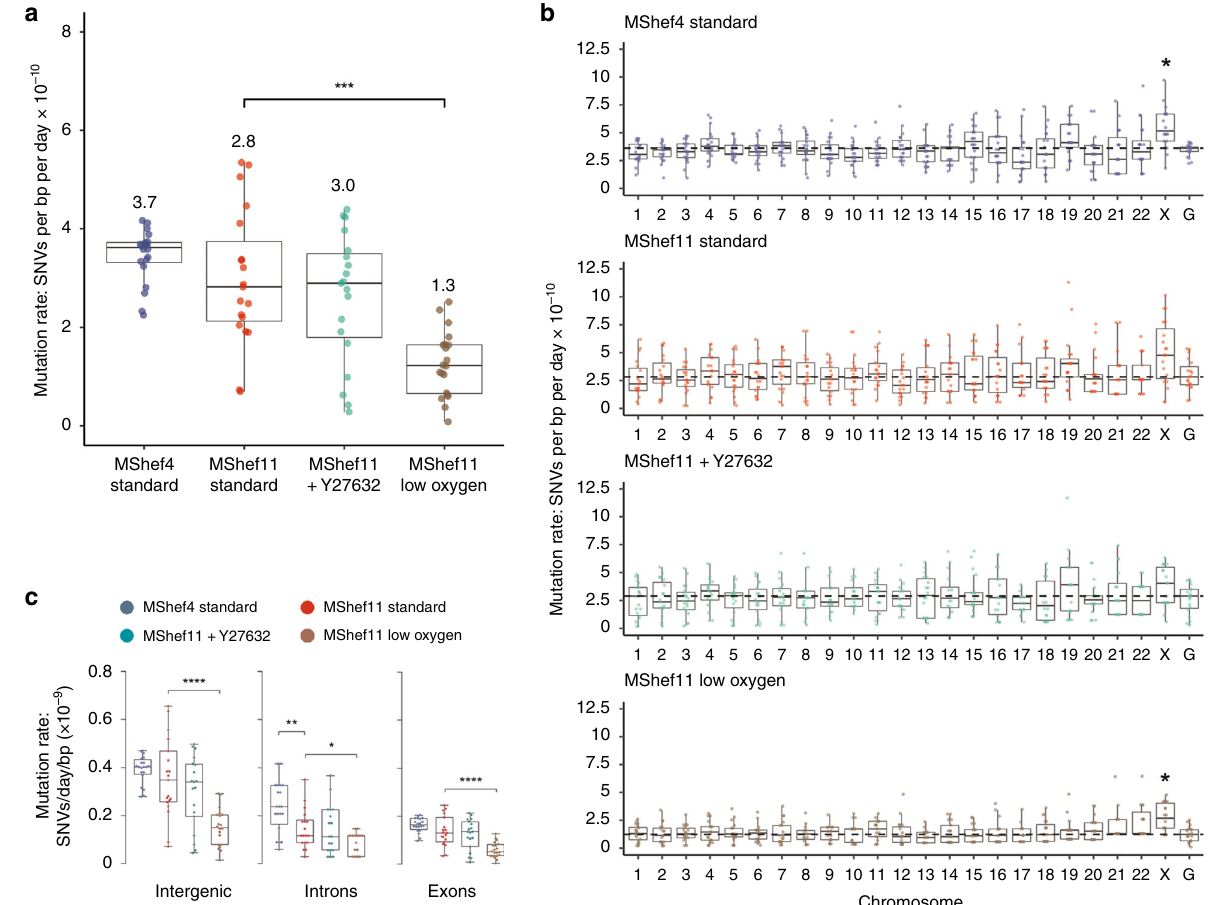
Fig. 2 Mutation rate and genomic distribution of single-nucleotide variant mutations in different growth-conditions. Box and whisker plots showing haploid mutation rates and genomic distribution of single-nucleotide variant mutations in subclones of MShef4 ( N = 20) and MShef11 ( N = 19) grown under standard conditions, and subclones of MShef11 cultured with the rho-kinase inhibitor Y27632 at passage ( N = 20) or cultured in low oxygen ( N = 21). Boxes represent 25th – 75th percentiles; whiskers show the min and max ranges; horizontal lines indicate the median values. a The median mutation rates (shown below each plot) for MShef4 and MShef11, cultured in standard conditions, and MShef11 cultured with the rho-kinase inhibitor Y27632 were not signi fi cantly different. However, MShef11 cultured in low oxygen exhibited a ~54% lower mutation rate (unpaired two-tailed t -tests with Welch ’ s correction; P = < 0.0001). ns: P > 0.05; * P ≤ 0.05; ** P ≤ 0.01, *** P ≤ 0.001; **** P ≤ 0.0001. b Across all chromosomes only the X-chromosome mutation rate deviated from the genome-wide rates, being elevated in all growth conditions, although only signi fi cant in MShef4 and MShef11 under low oxygen, assessed by independent pairwise two-tailed Mann-Whitney tests comparing the median genome-wide rate in each condition with that of each chromosome (Bonferroni-adjusted P = < 0.007; P = < 0.034). When data from all growth conditions were combined, the elevated X-chromosome mutation rate remained signi fi cant ( P = < 0.05). ns: P > 0.05; * P ≤ 0.05; ** P ≤ 0.01, *** P ≤ 0.001; **** P ≤ 0.0001. c Across coding and non-coding regions, normalised to the genomic DNA content of each class of region, under each growth-condition intergenic DNA showed higher mutation rates than exons and introns. For intergenic DNA: MShef11 standard vs MShef11 low oxygen P < 0.001; For intronic DNA: MShef4 standard vs. MShef11 standard P =